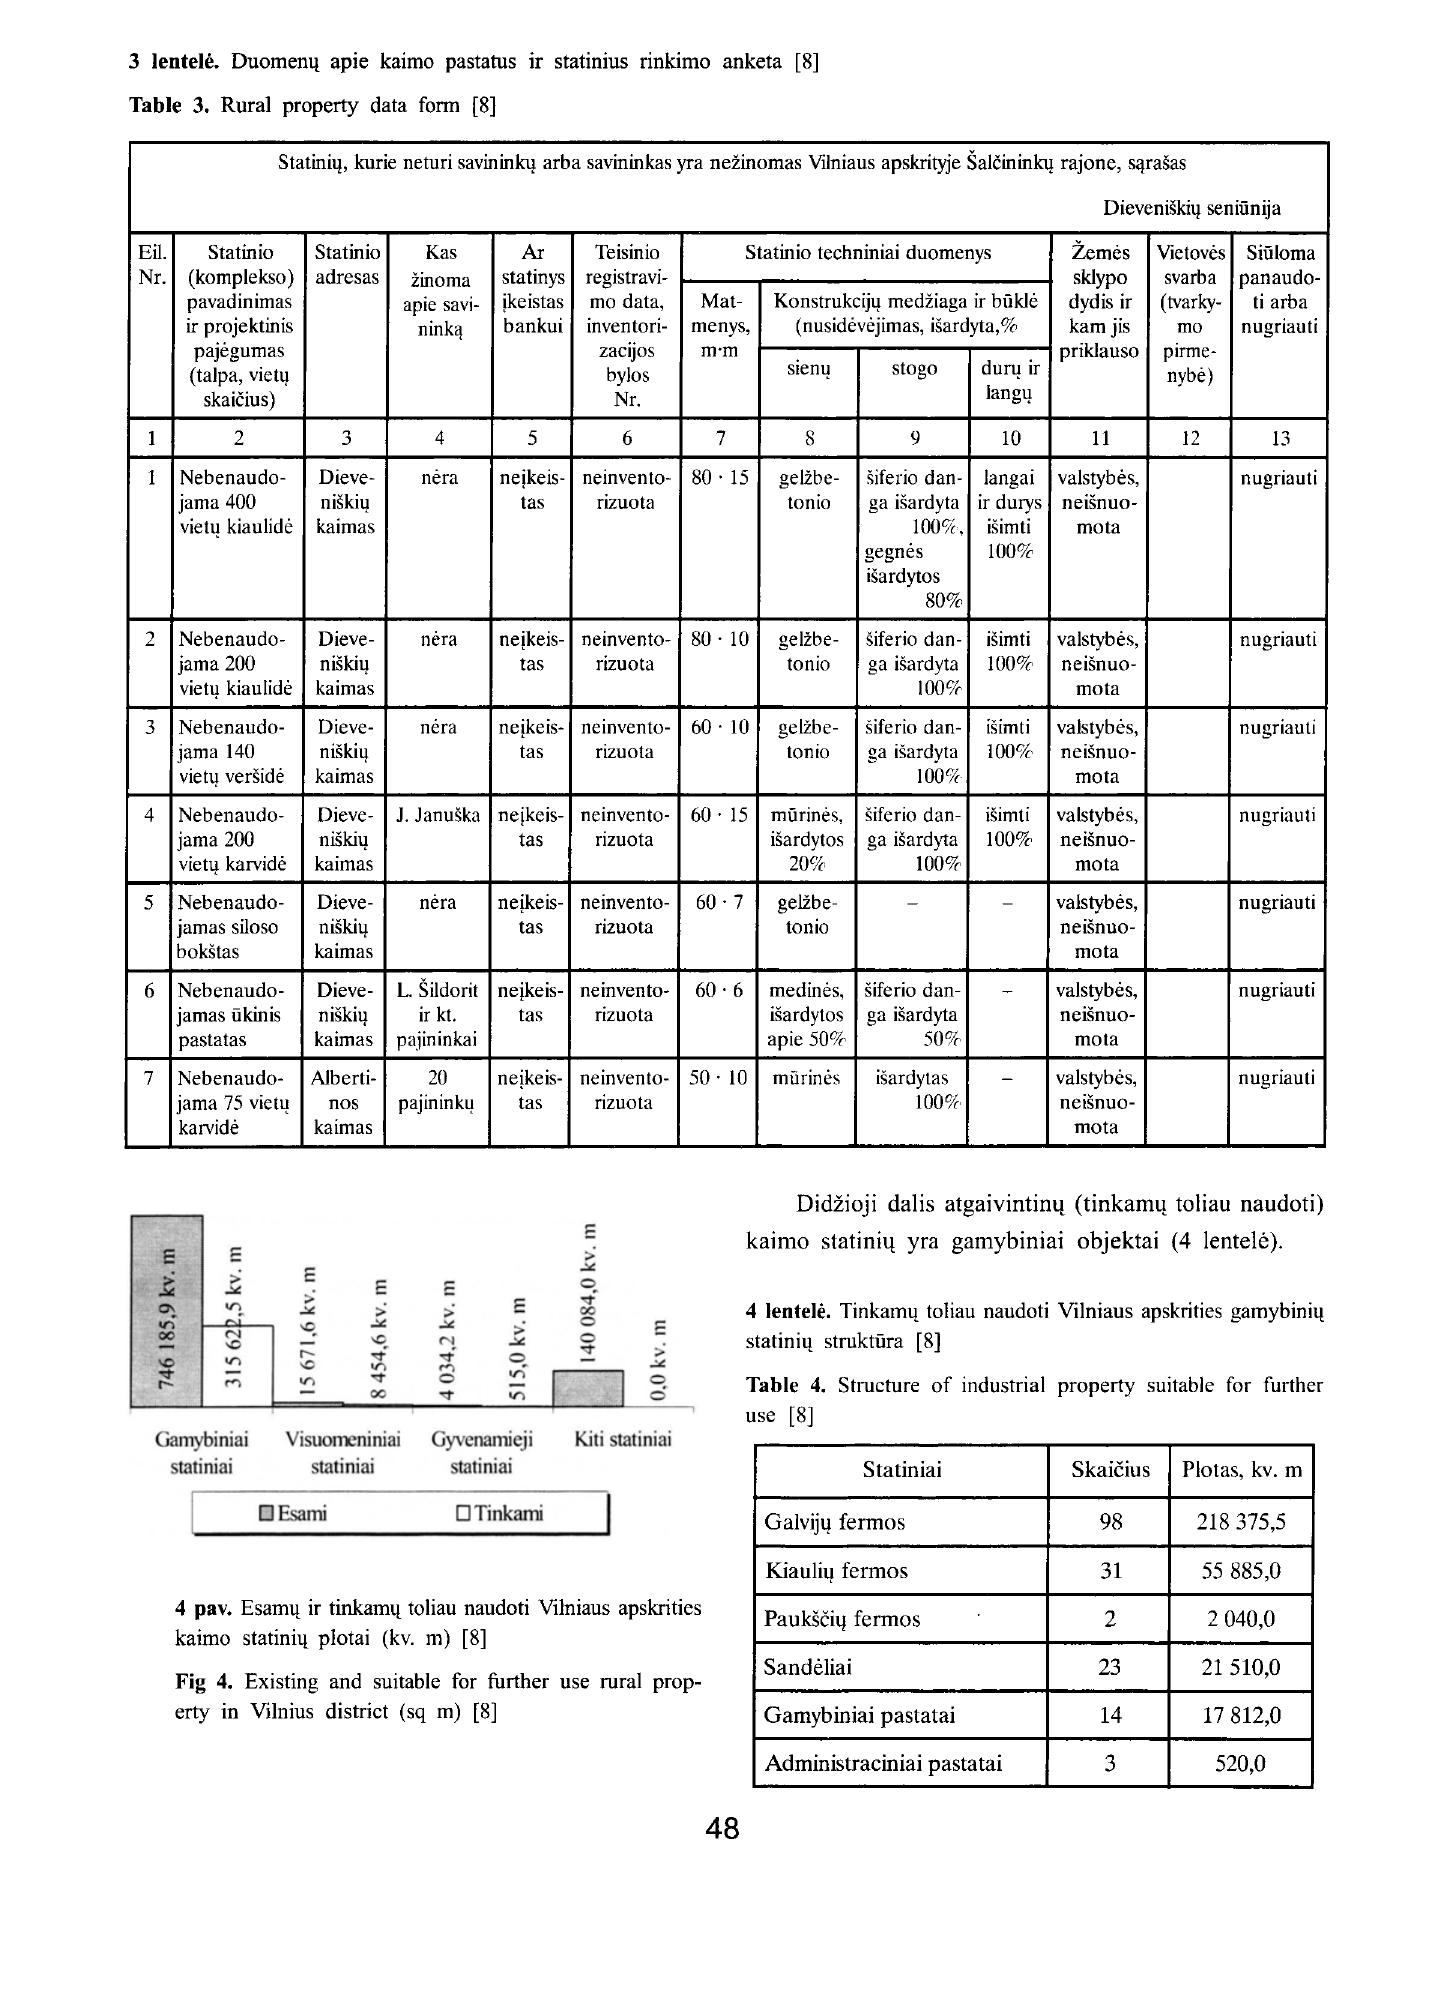
Table 3. Rural property data form [8]